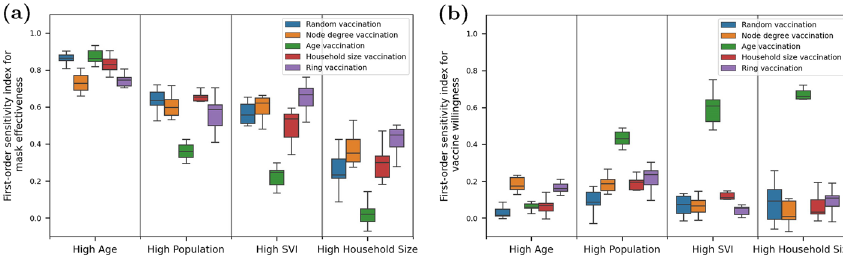
Fig. 8 Distribution of first-order sensitivity for a mass effectiveness and b vaccine willingness on